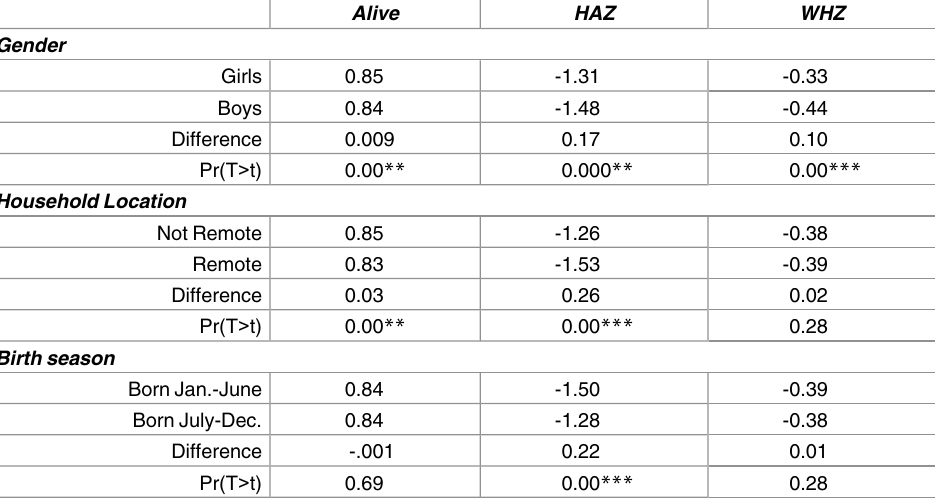
Table 3. Two-sample T-tests with equal variances.